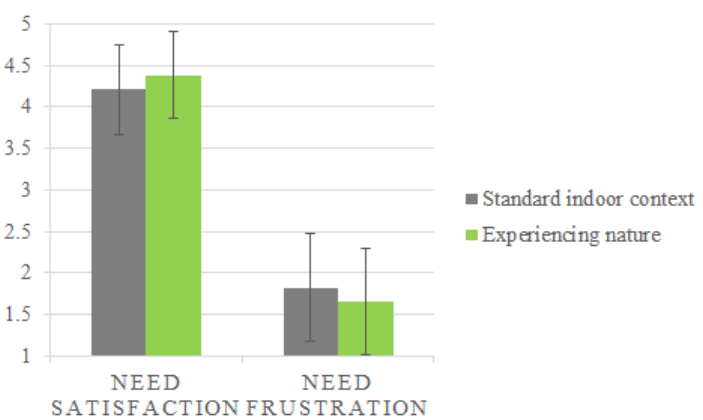
Figure 2. Means with error bars (1SD) for need satisfaction and need frustration in the standard indoor context and while experiencing nature. Table 2. Multilevel regression of the association between experiencing nature as opposed to being in the indoor context and parental need satisfaction and parental need frustration; regression coefficient B with 95% confidence intervals, converted to Cohen’s d with 95% CI.